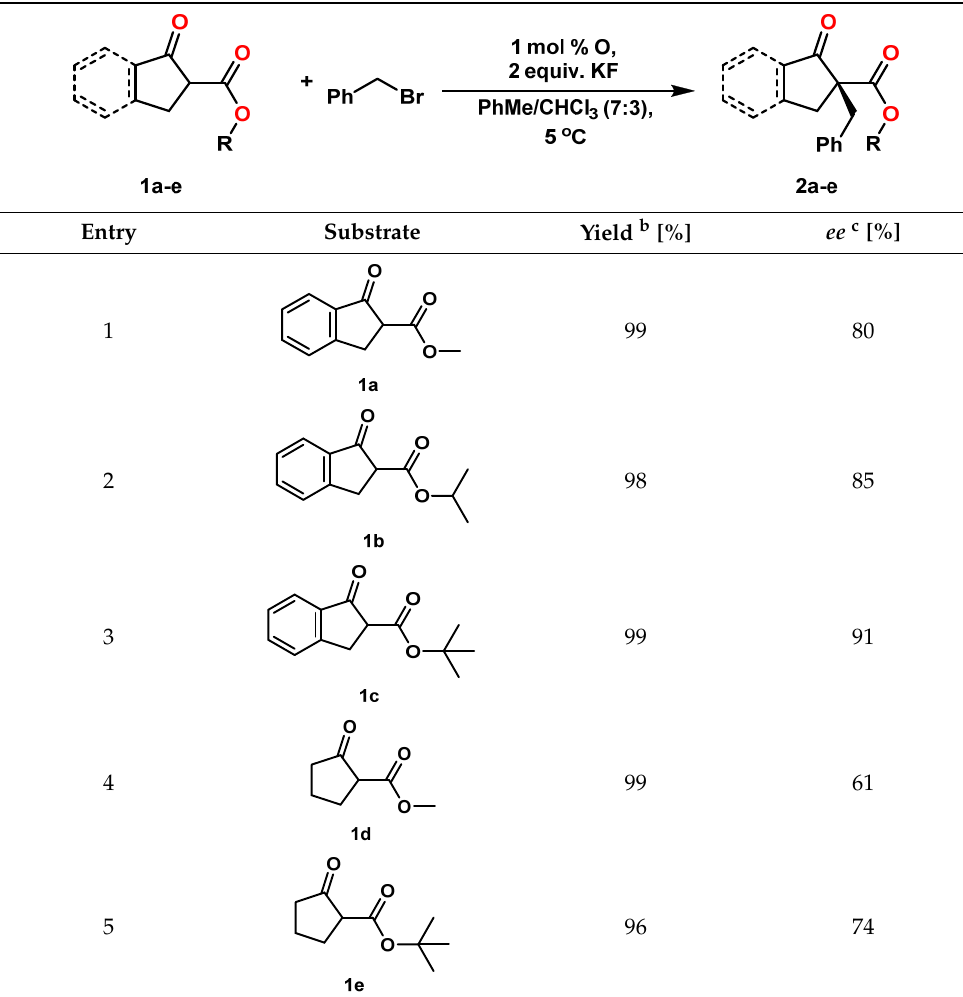
Table 3. Screening of β -keto esters 1a – e a .